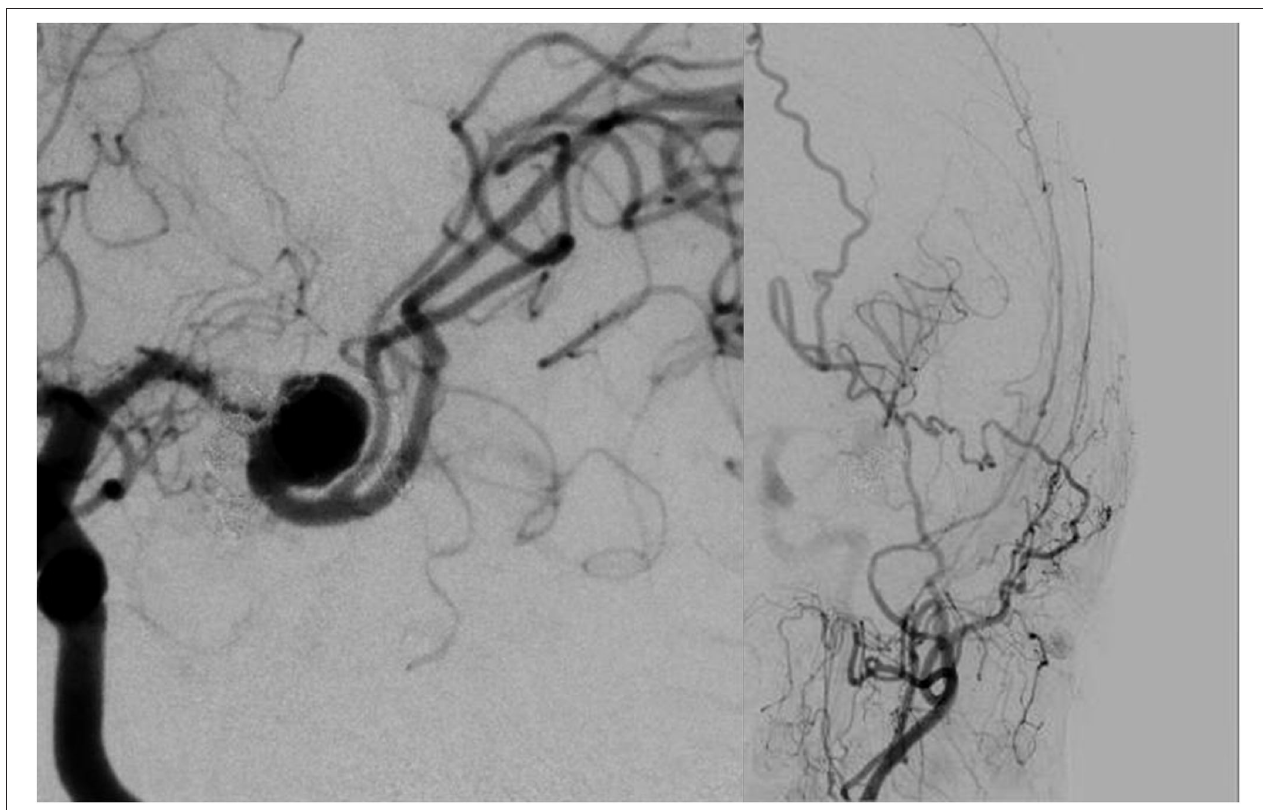
FIGURE 3 | Postoperative angiography of first session reveals sacrifice of superior trunk “that is transformation to side-wall-type aneurysm” (left) and good patency of bypass (right).